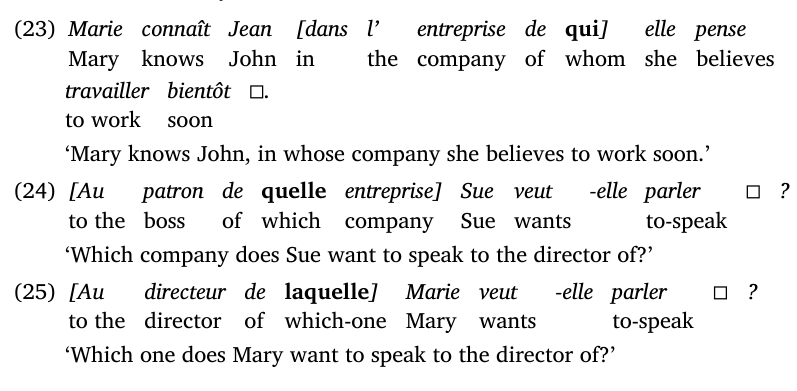
The three sentences below illustrate the phenomenon. In each example, the extracted constituent is put in square brackets and the grammatical word triggering extraction, called wh-word in the follow- ing, is displayed in bold type. The trace of the extracted constituent is marked with the symbol □